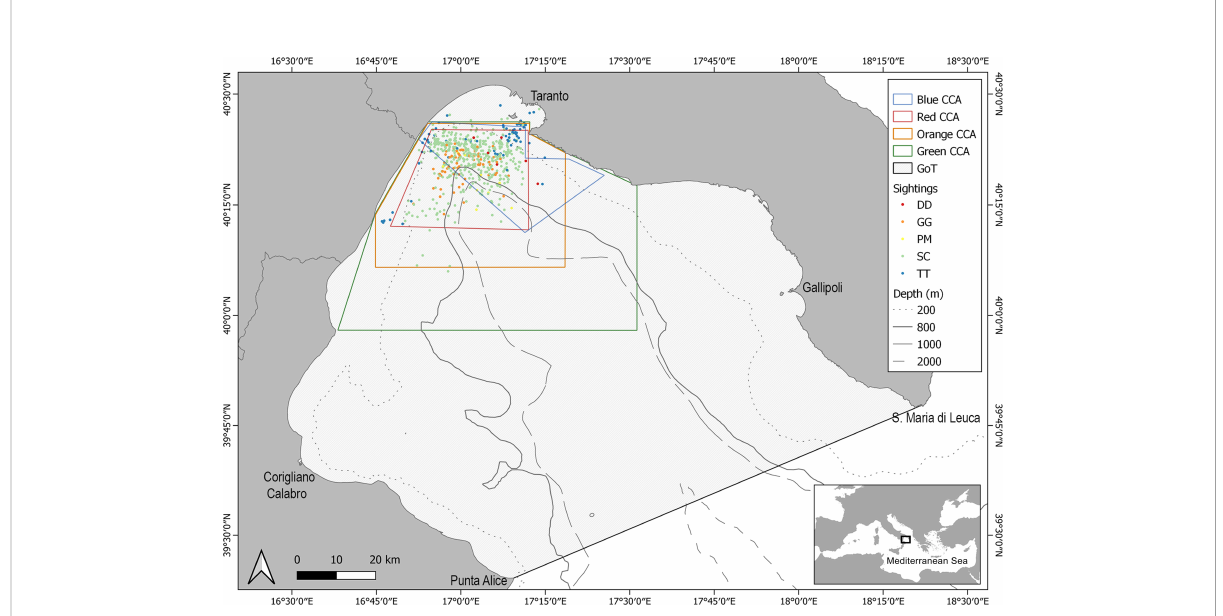
FIGURE 1 Map of the Northern Ionian Sea (Central Mediterranean Sea) with sightings distribution of S. coeruleoalba (SC), D. delphis (DD), G. griseus (GG), T. truncatus (TT), P. macrocephalus (PM) and the spatial limits of CCAs (the black line indicates the border of the